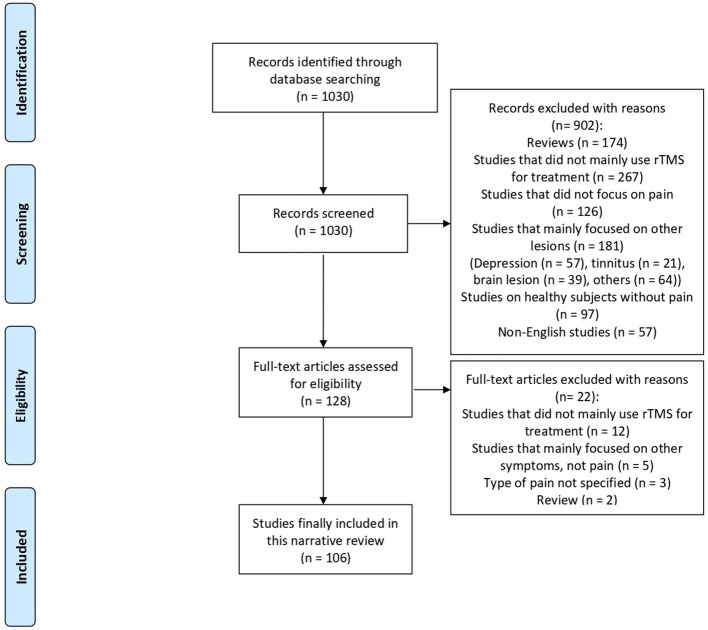
Flow chart showing the search results for the study.